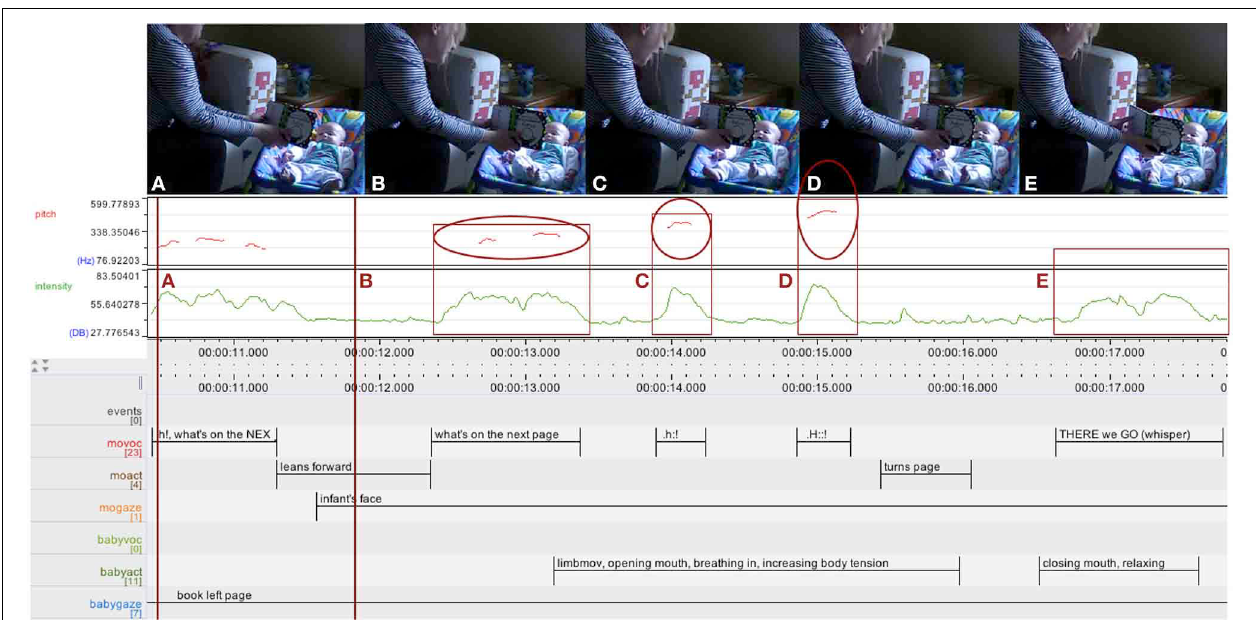
FIGURE 6 | ELAN analysis detail showing pitch (red) and intensity (green) curves. The mother is building up an action arc through surprise exclamations of increasing intensity and pitch before releasing the tension through a quick